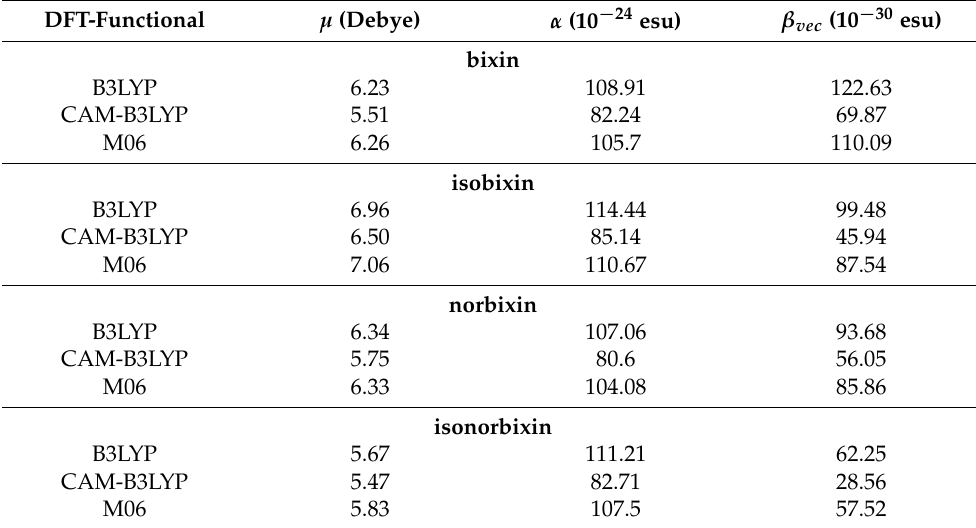
Table A13. Dipole moment ( µ ), average linear polarizability ( α ), and vector component of the first ( β vec ) hyperpolarizability of the dyes in gas phase. These results were obtained by employing the 6-31G basis set.